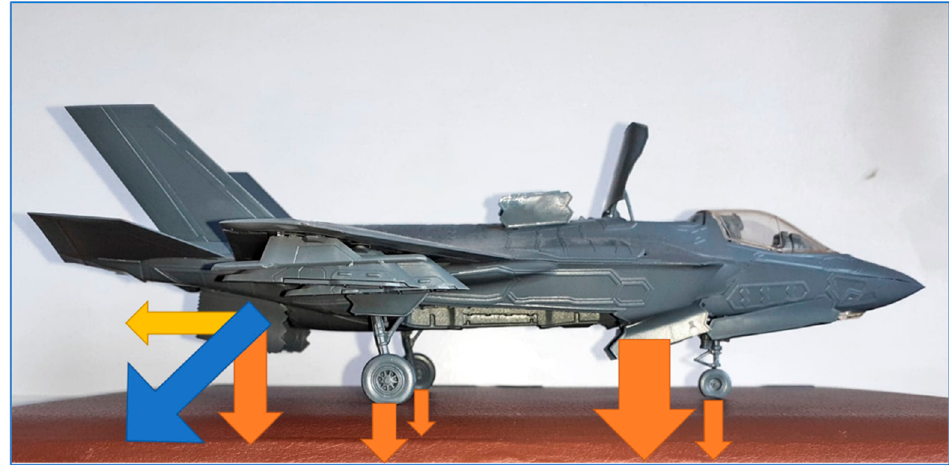
Figure 7. The directions of the dynamic forces acting on a flat deck considered in the analyses. The downward component for the jet was calculated as: